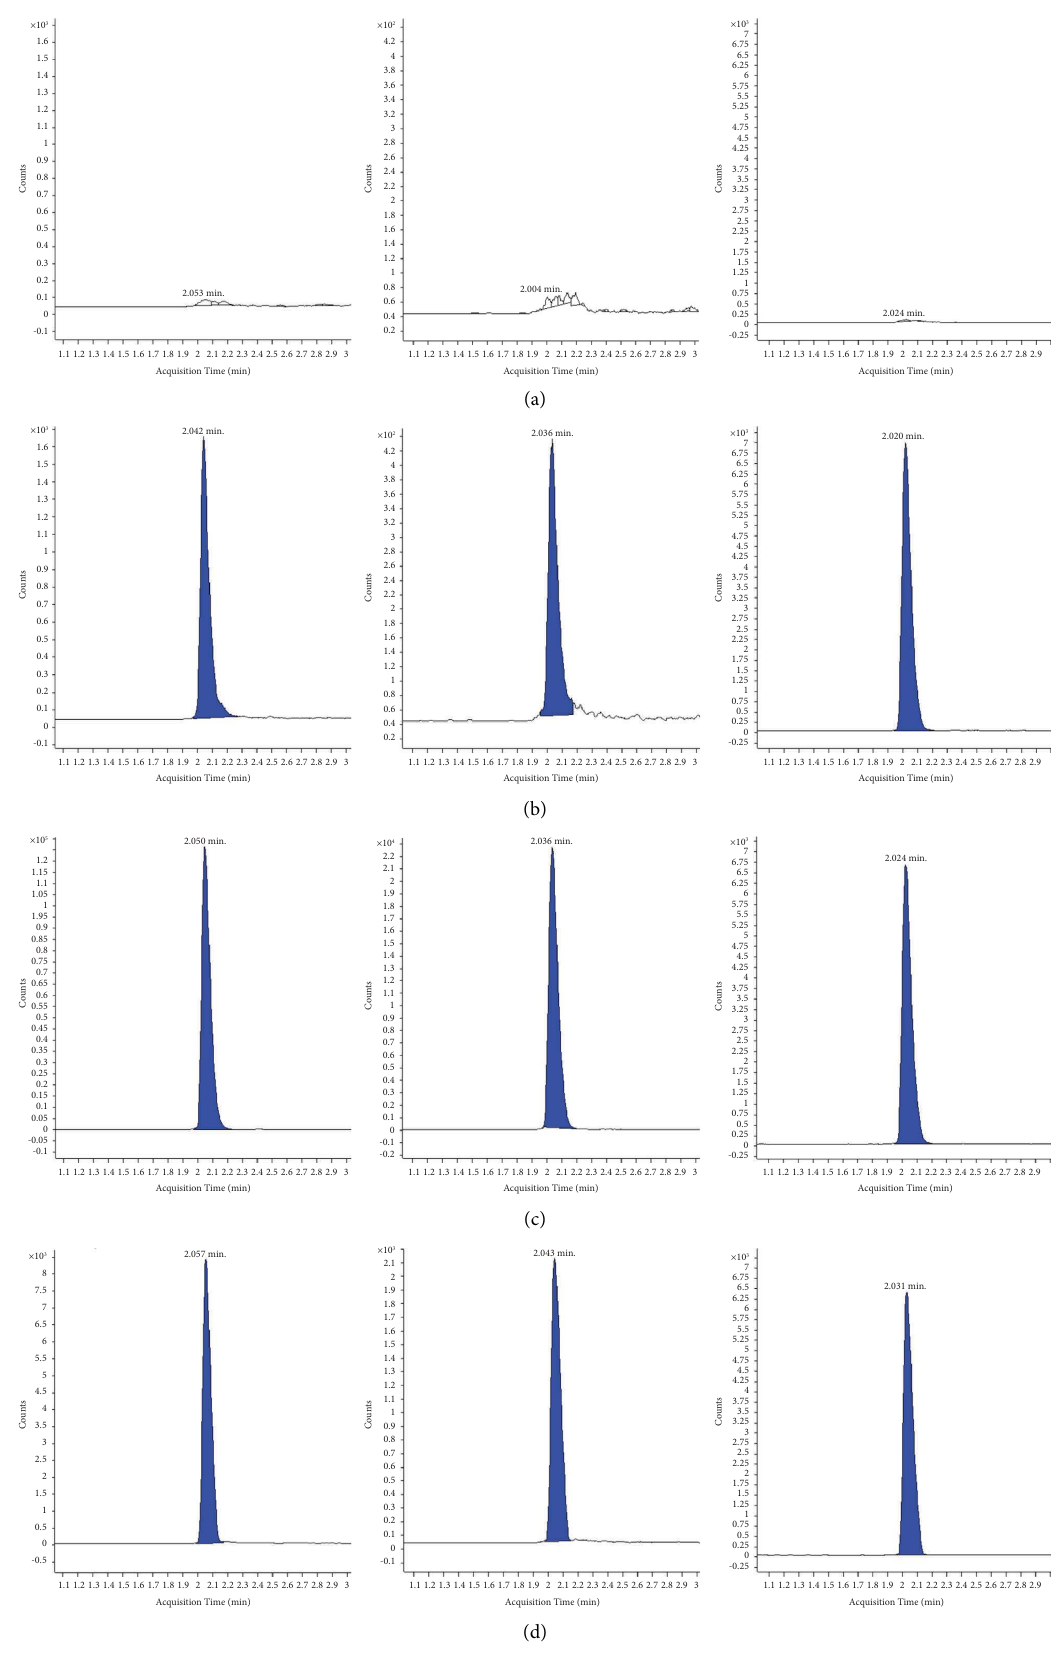
Figure 3: Te chromatograms of PB and IS in human plasma. Te left is PB1/PB1-I; the middle is PB2/PB3; and the right is IS. (a) Blank plasma sample; (b) plasma standard of LLOQ; (c) plasma standard of ULOQ; (d) clinical plasma